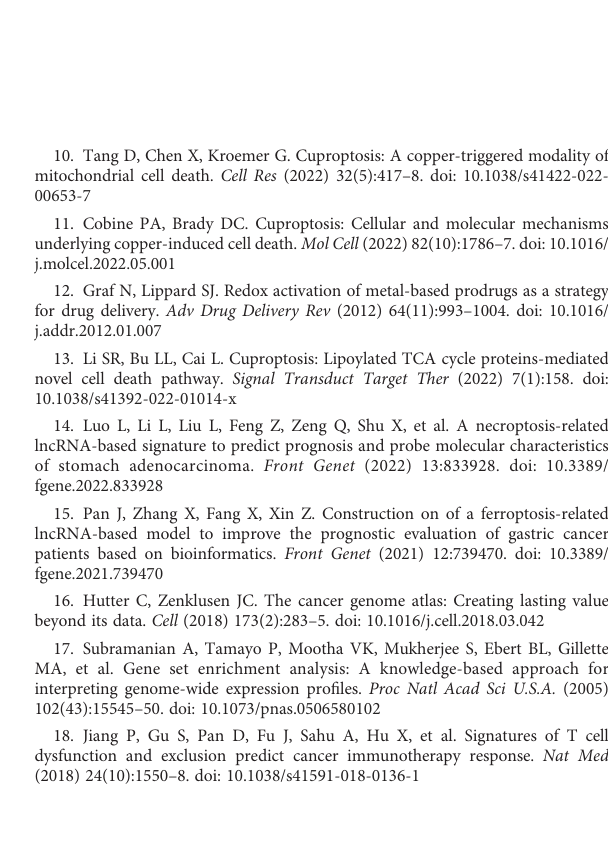
SUPPLEMENTARY FIGURE 1 Sanki diagram of lncRNA-mRNA co-expression